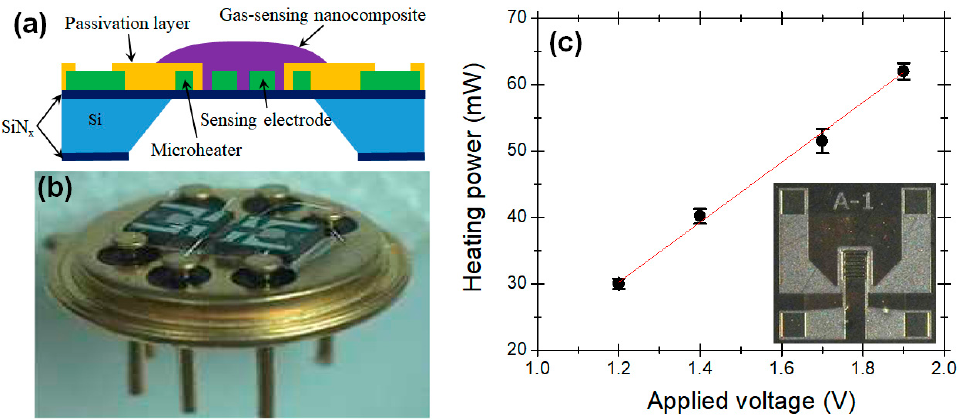
Figure 2. Physical characterization of the fabricated dual ‐ sensor module: ( a ) cross ‐ sectional view of the arrayed gas ‐ sensor package, ( b ) photograph of a dual ‐ sensor module, ( c ) output power vs. applied voltage curve of the microheater.